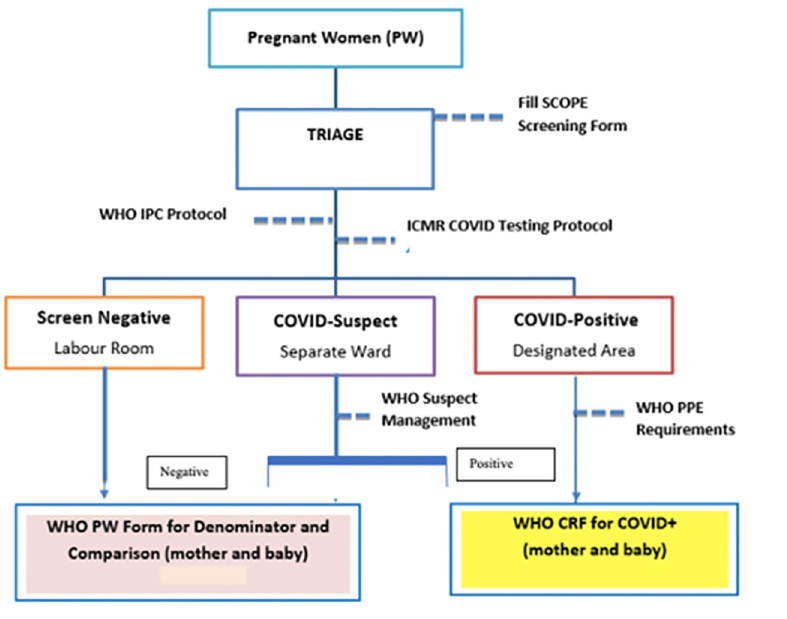
Fig 1. Patient recruitment flow